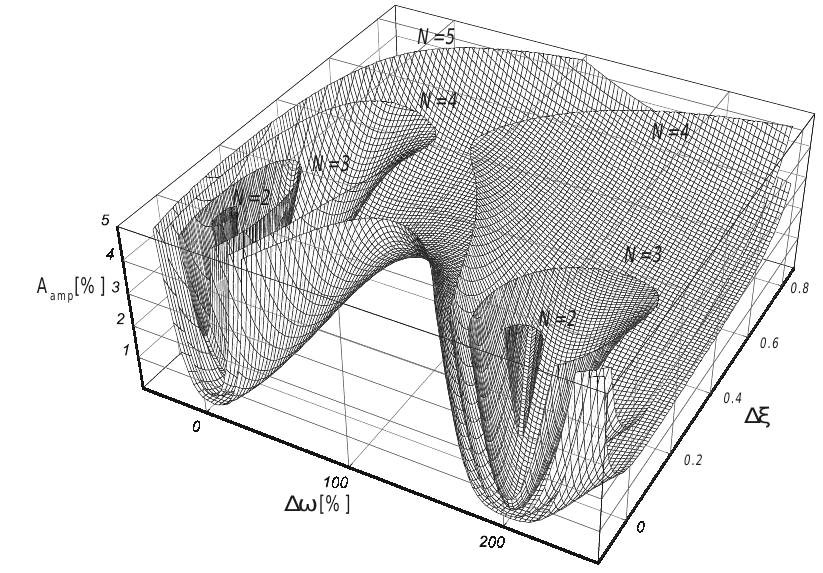
Fig. 1. Amplitude at the end of the pulse sequence with maximum overshoot A amp < 0 . 05 , low damping ratio ( ζ = 0 . 1) .